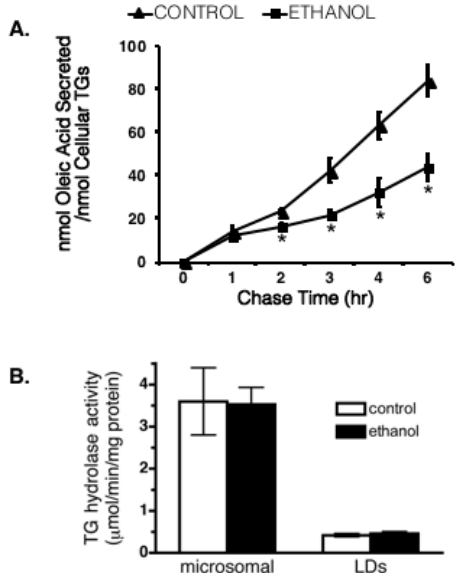
Figure 1. Male Wistar rats on an ethanol-enriched Lieber – DeCarli diet develop fatty liver. ( A ) Confocal images of representative liver sections stained with BODIPY (green, LDs) and DAPI (blue, nuclei). ( B , C ) Chronic ethanol exposure increased the diameter and number of hepatic LDs. Values are mean ± SEM from nine fields of view of liver sections from five control and five ethanol-fed animals. Data were analyzed by ANOVA followed by Tukey ’s test for specific comparisons between means (*, p < 0.05).